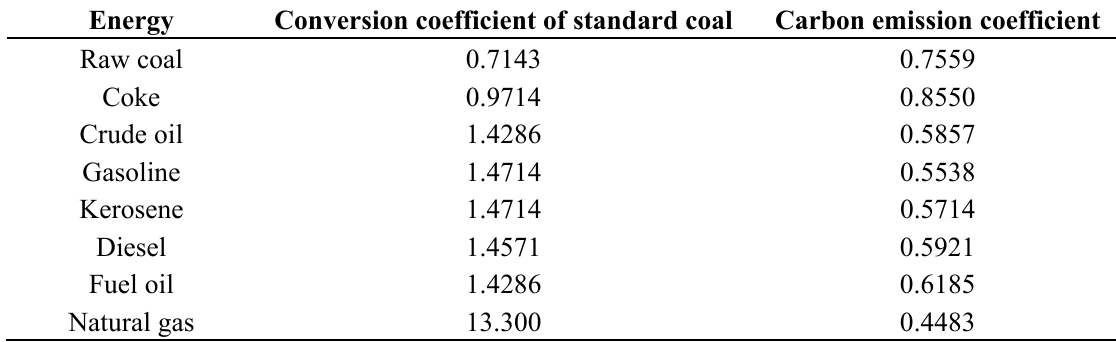
Table 1. Parameters for calculating carbon